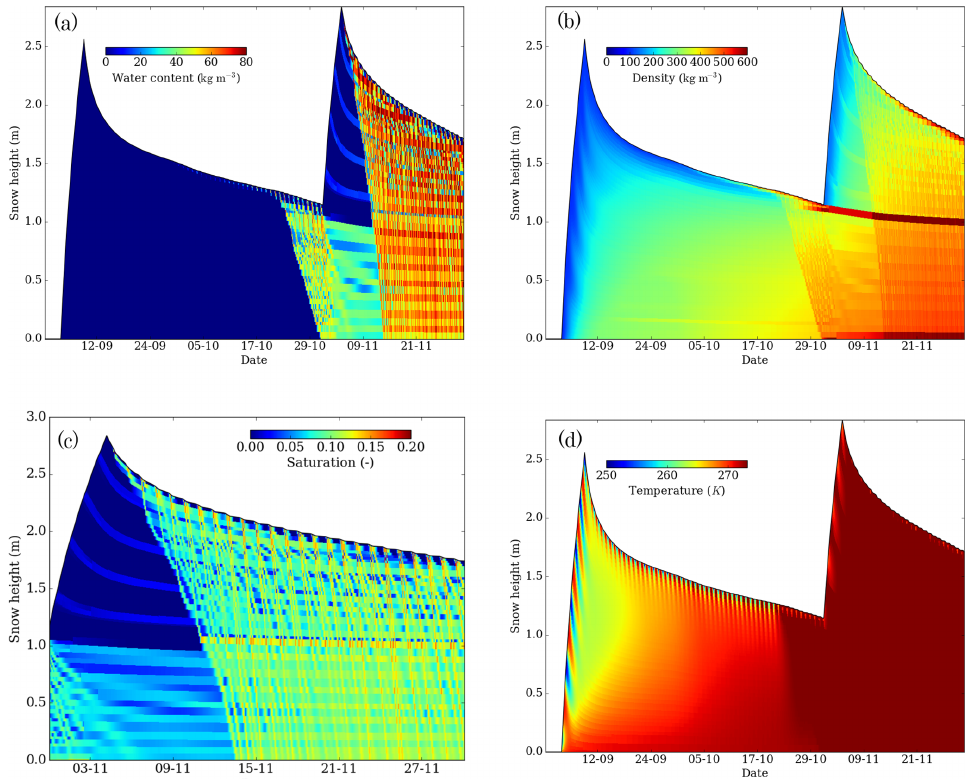
Figure 8. Crocus output for simulated forcing using the Richards routine with T Crocus = 900s (15min). The bottom boundary is set to free flow, with θ min = 10 − 5 . (a) Liquid water amount, (b) snow layer density, (c) percentage of pore volume filled with water zoomed in on the second snow event and (d) temperature development of the